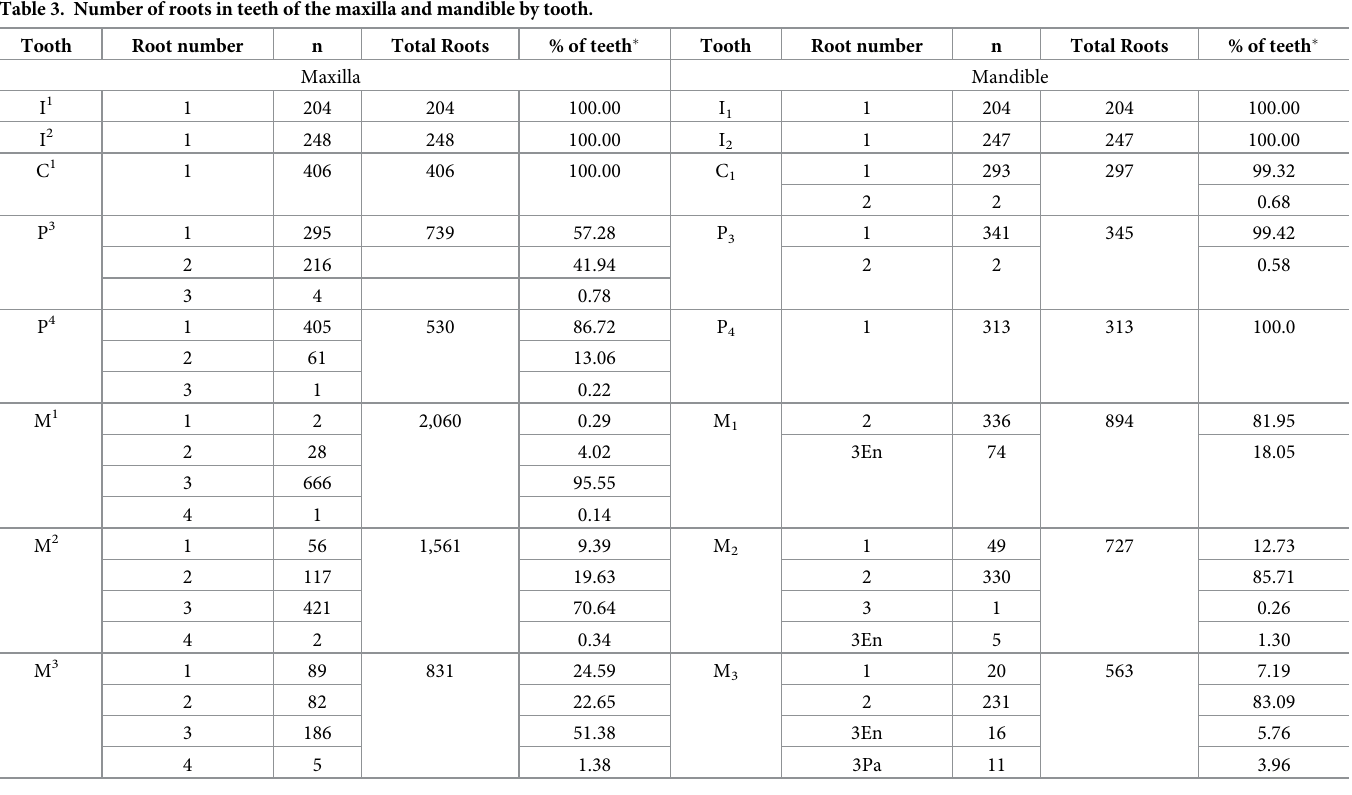
� From Table 2. Congenitally absent teeth not included in statistics for this table. En = Entomolaris, Pa =